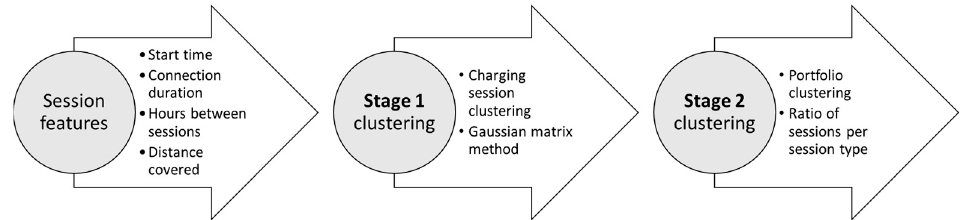
Figure 9. Overview of hybrid method for EV clustering proposed in [61].